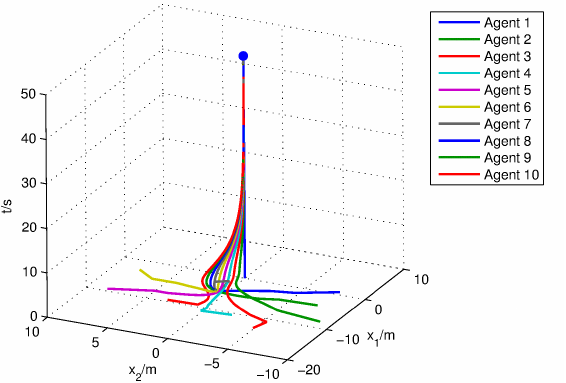
Figure 3. The spatio-temporal trajectory of mobile sensors.